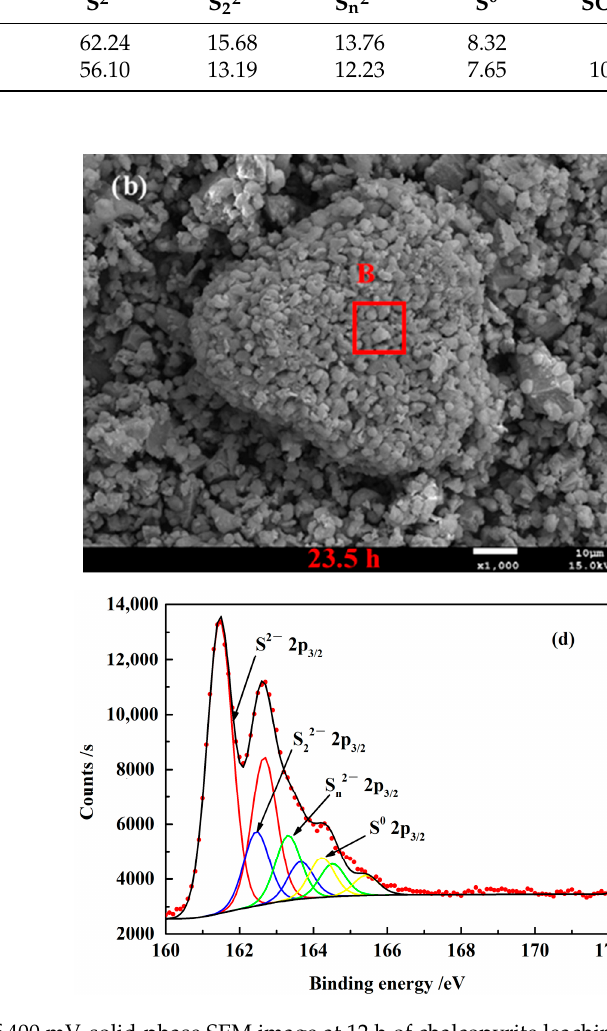
Figure 6. In the experimental group with redox potential of 400 mV, solid-phase SEM image at 12 h of chalcopyrite leaching ( a ), and solid-phase SEM image ( b ), XRD image ( c ), and XPS image ( d ) at 23.5 h of chalcopyrite leaching. (A and B in the figures are EDS detection areas). Table 3. EDS results of the leaching residue.